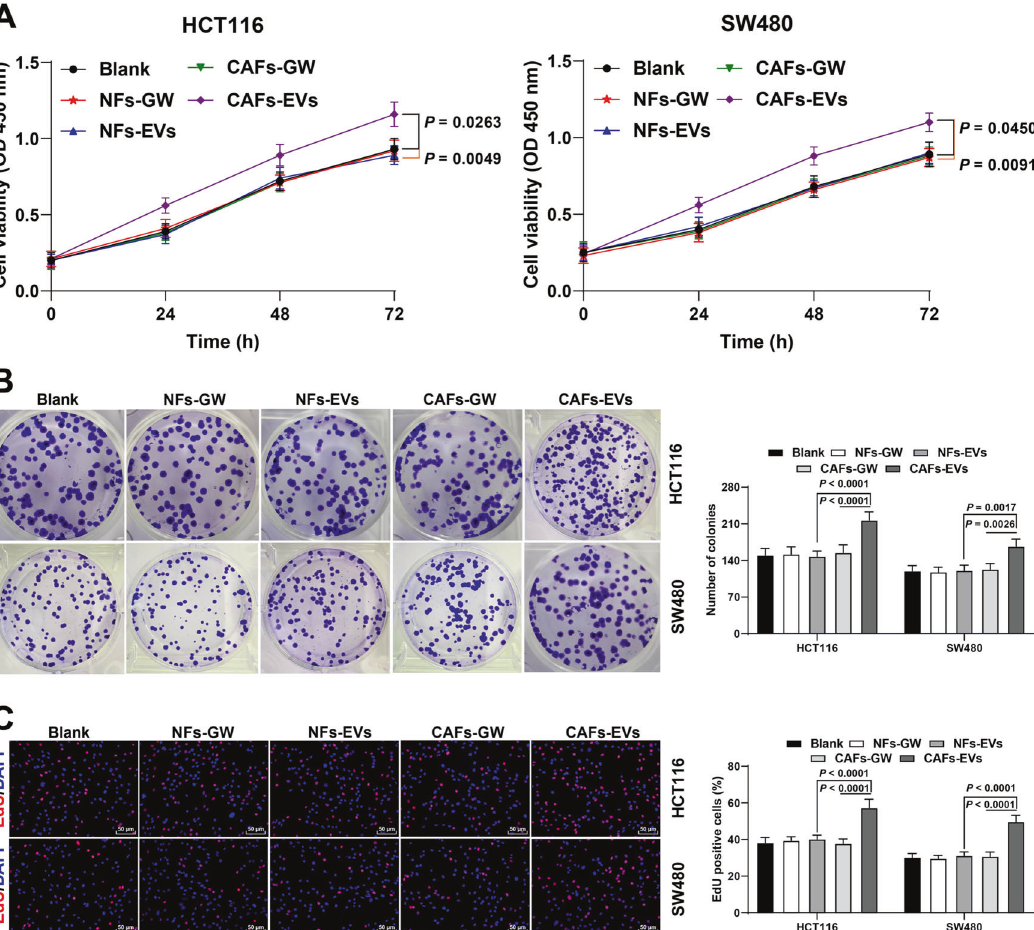
Fig. 1 CAFs-EVs promoted the proliferation of CRC cells. CRC cells were treated with NFs-EVs and CAFs-EVs, with NFs-GW and CAFs-GW treatment as negative control. A – C The cell proliferation ability was measured using CCK-8 assay ( A ), colony formation assay ( B ), and EdU staining ( C ). The cell experiment was repeated 3 times independently. Data are presented as mean ± standard deviation. Data in panel A were analyzed using two-way ANOVA, and data in B , C were analyzed using one-way ANOVA, followed by Tukey ’ s multiple comparisons